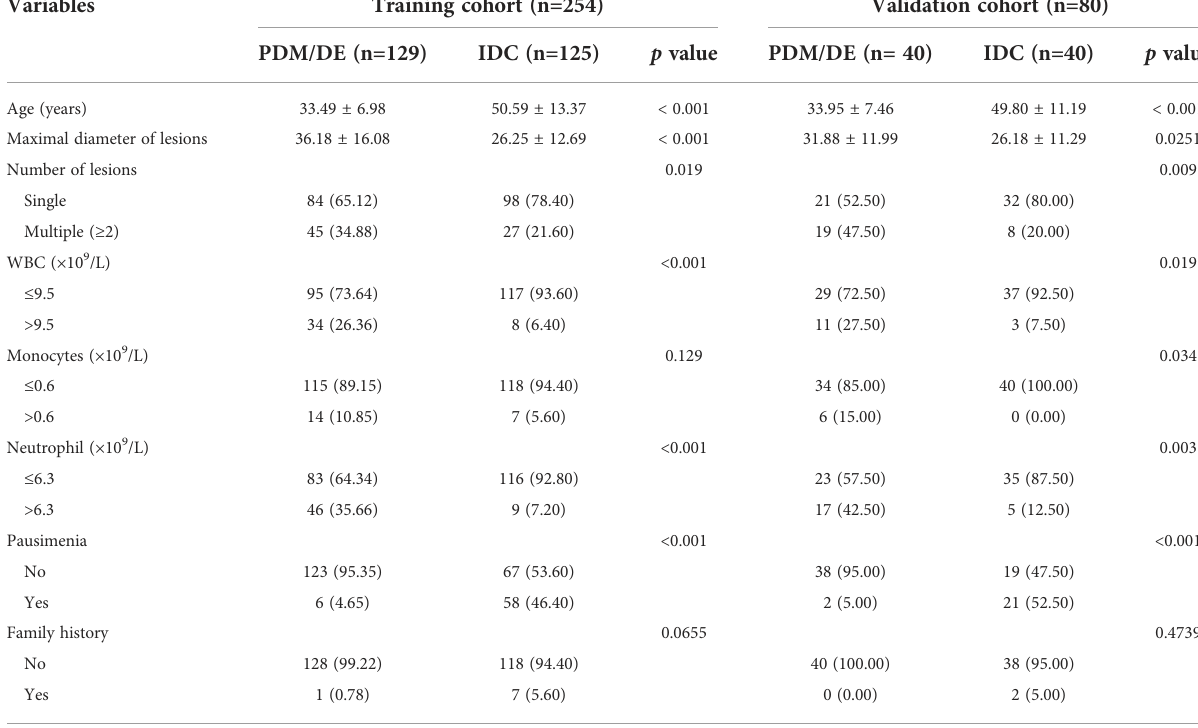
TABLE 1 Clinical characteristics of patients on the training and validation